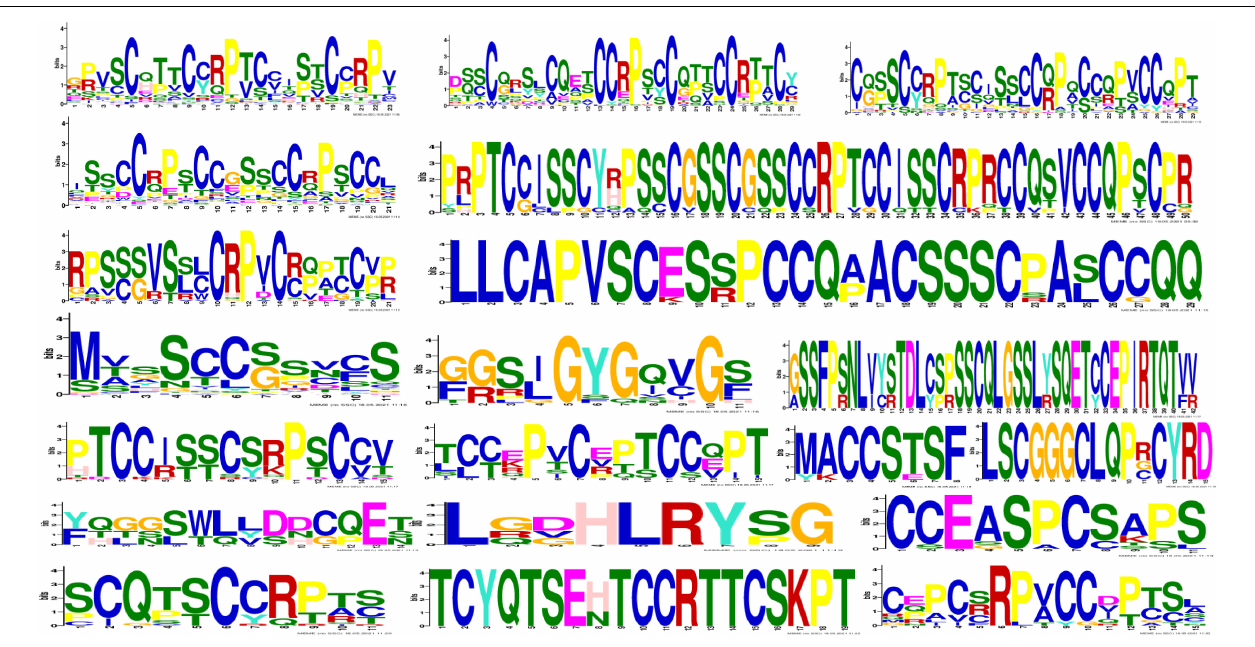
FIGURE 3 | Amino acid frequency of 20 conserved motifs. Each letter represents an amino acid; the larger the letter in a motif, the higher is amino acid